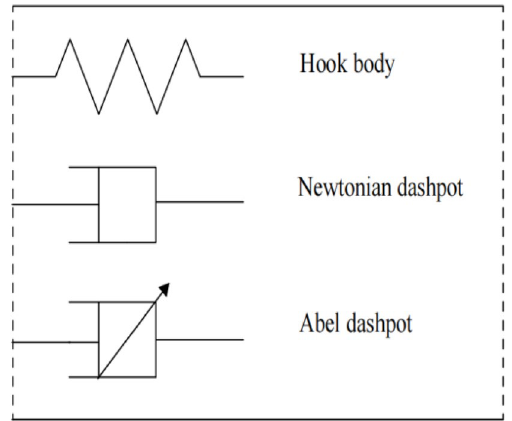
Figure 5. Basic element model.